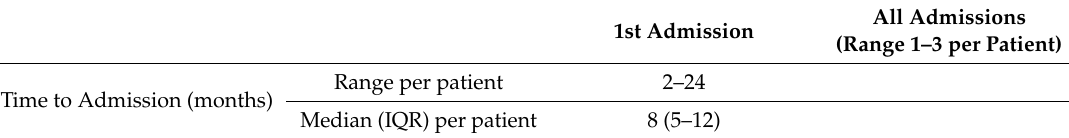
Table 1. Time to hospital readmission, length of stay and costs for fracture healing complication admissions within two years of original fracture ( n = 343 admissions for n = 315 patients).